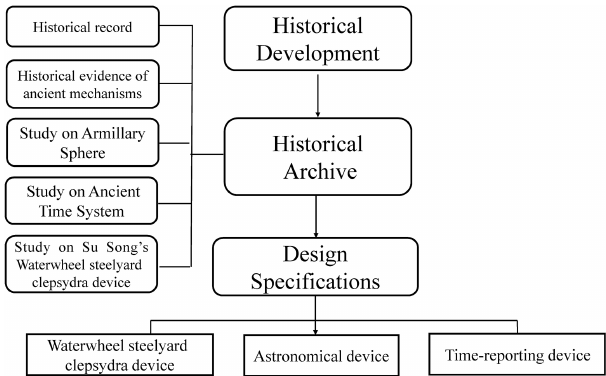
Figure 3. Historical development and design